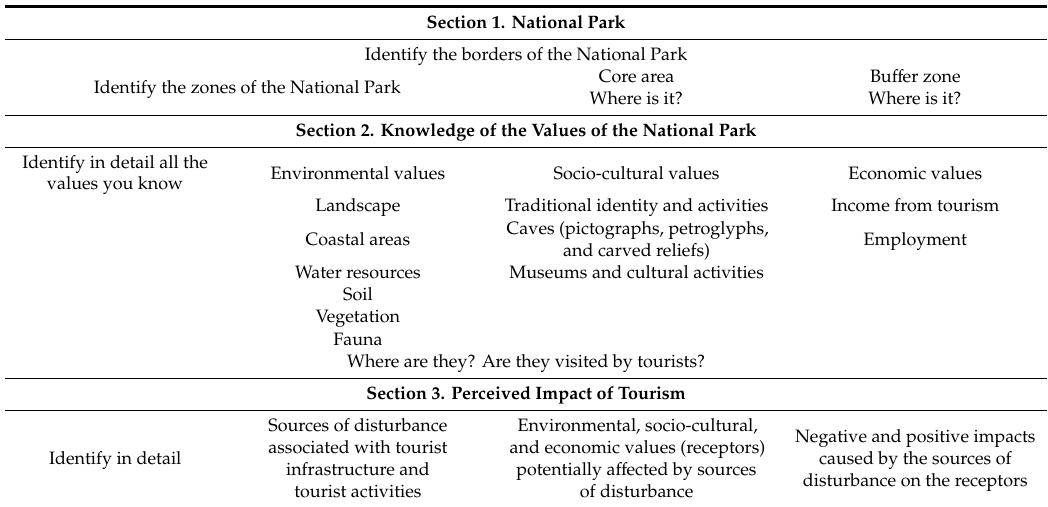
Table 3. Questionnaire structure with the most relevant questions.